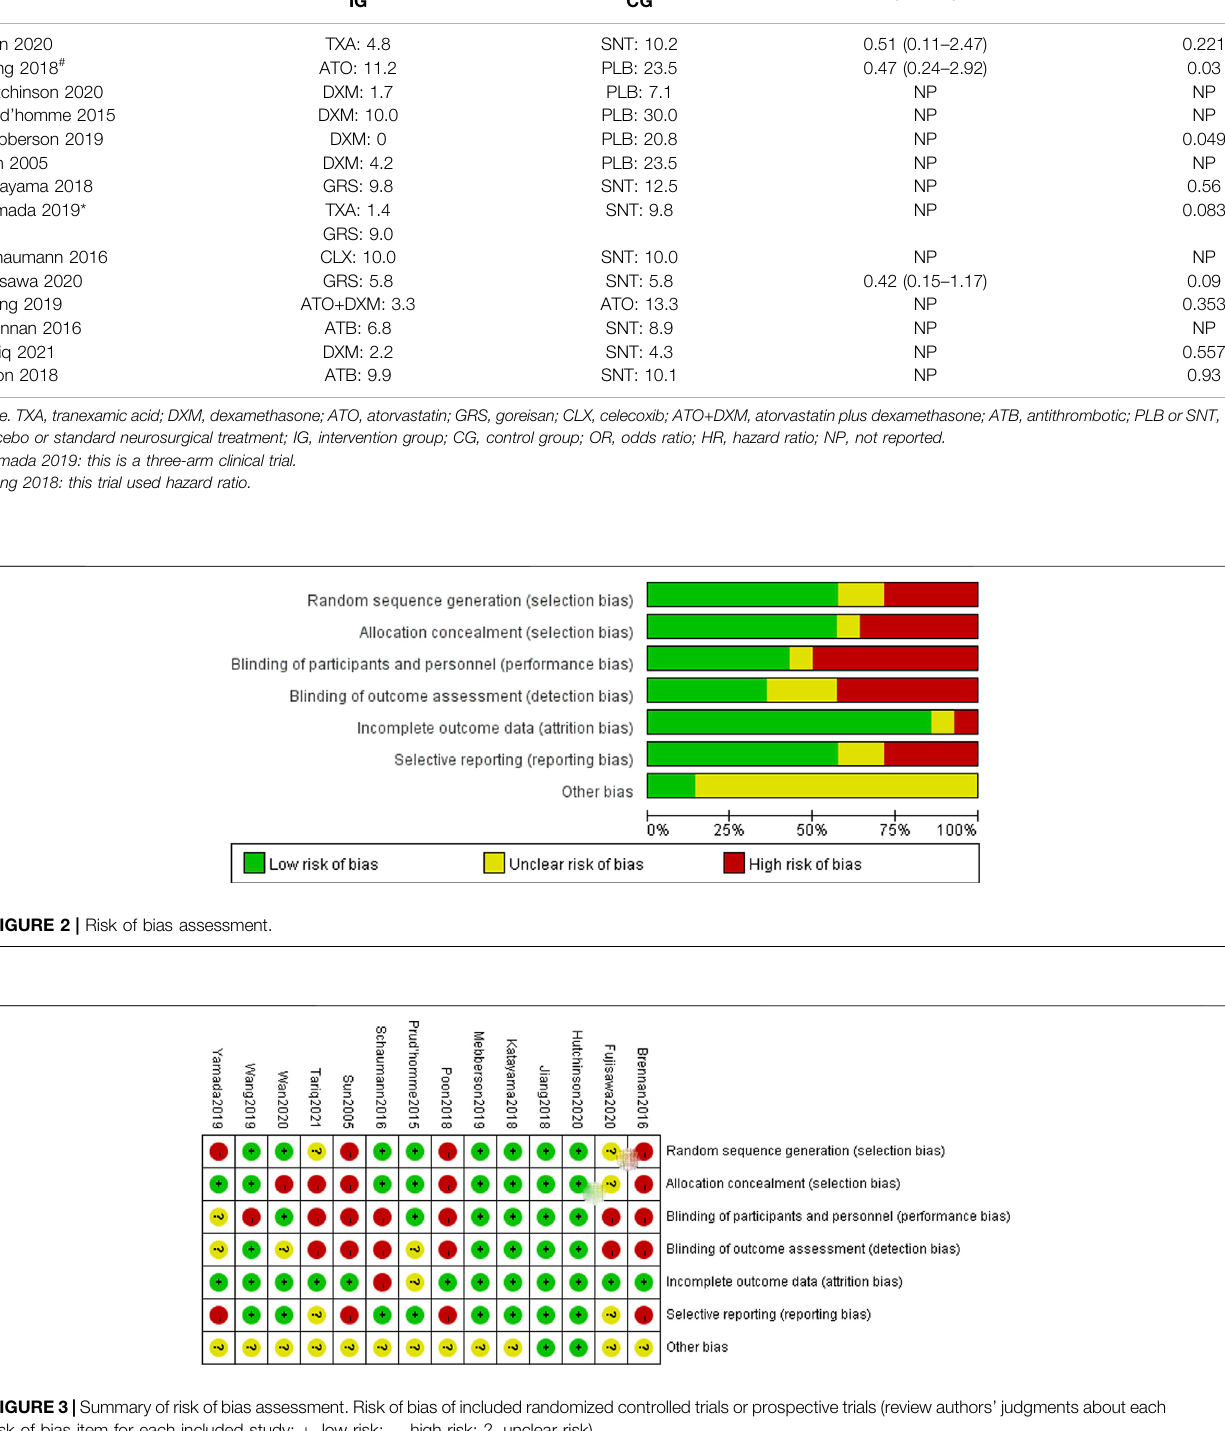
FIGURE 3 | Summary of risk of bias assessment. Risk of bias of included randomized controlled trials or prospective trials (review authors ’ judgments about each risk of bias item for each included study: +, low risk; − , high risk; ?, unclear